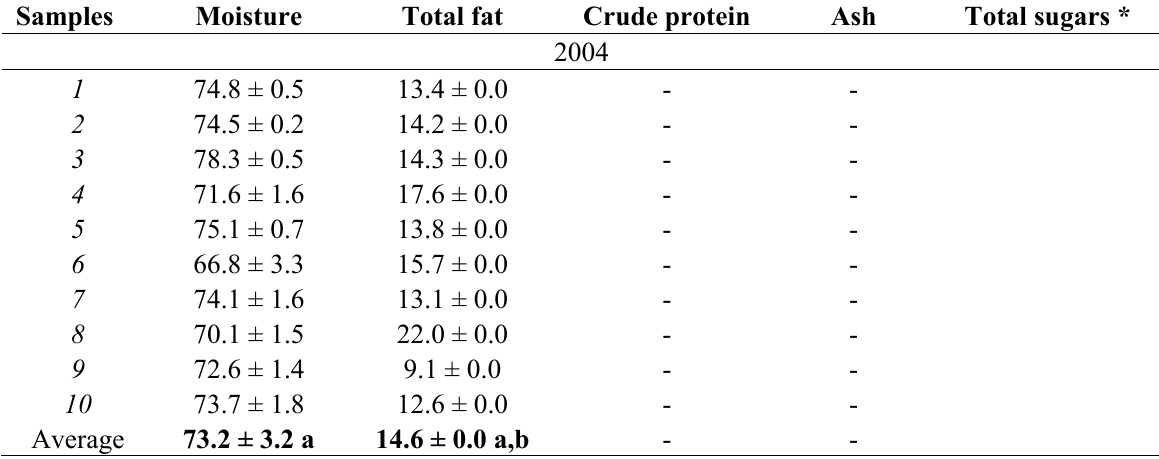
Table 1. Proximate chemical composition (grams per 100 g of fresh weight) of “ alcaparras ” stoned table olives samples from three different years of production.